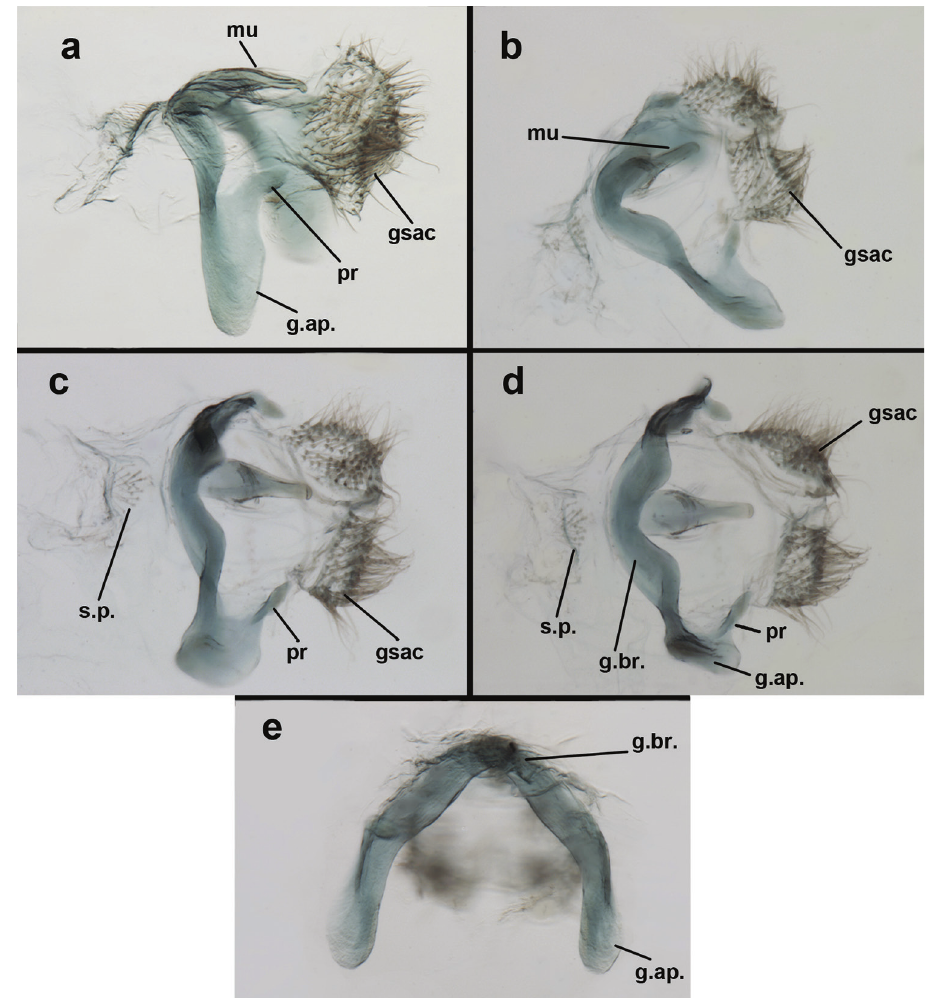
Figure 80. Ungla quchapampa Tauber, sp. n. Male genitalia, ( a ) gonarcal complex, frontolateral, with gonosaccus expanded ( b ) gonarcus, dorsolateral, with gonosaccus fully expanded [Note close connec- tion between mediuncus and gonarcal bridge.] ( c, d ) gonarcus dorsal, gonosaccus expanded ( e ) gonar- cus, posterior, gonosaccus in distance. gsac gonosaccus g.ap. gonarcal apodeme g.br. gonarcal bridge mu mediuncus pr unarticulated process on frontal margin of gonarcal apodeme s.p. setose subanal plate (Bolivia, Cochabamba, holotype,